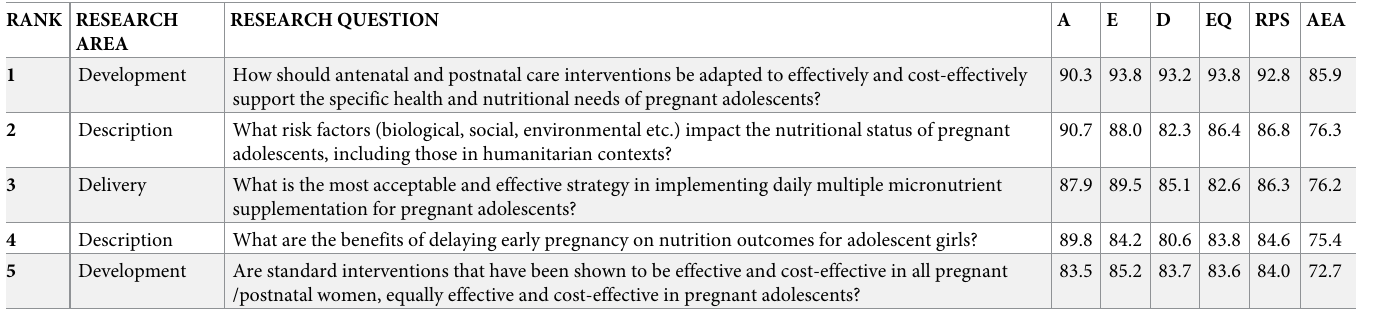
Table 5. Top five ranked research questions for pregnant adolescents